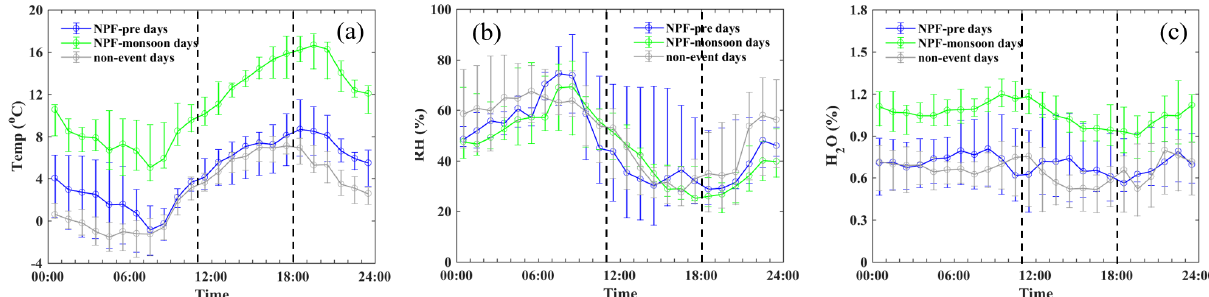
Figure 6. Diurnal variations of (a) temperature, (b) RH and (c) the water content (H 2 O) in the air on NPF-pre days, NPF-monsoon days and non-event days. The upper and lower bars indicate the 75th and 25th percentiles; the markers are the average